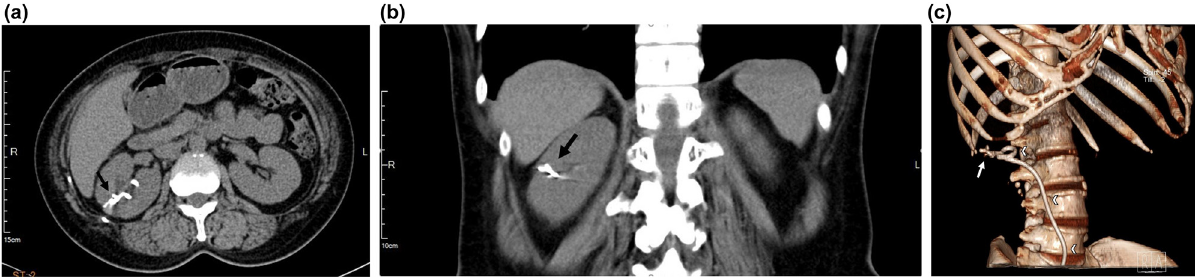
Figure 2: Computed tomography image of the intrarenal foreign body ( arrow ) and its relationship with right double J ureter stent ( arrow - heads ) . ( a ) Transverse cut, ( b ) coronal cut, and ( c )